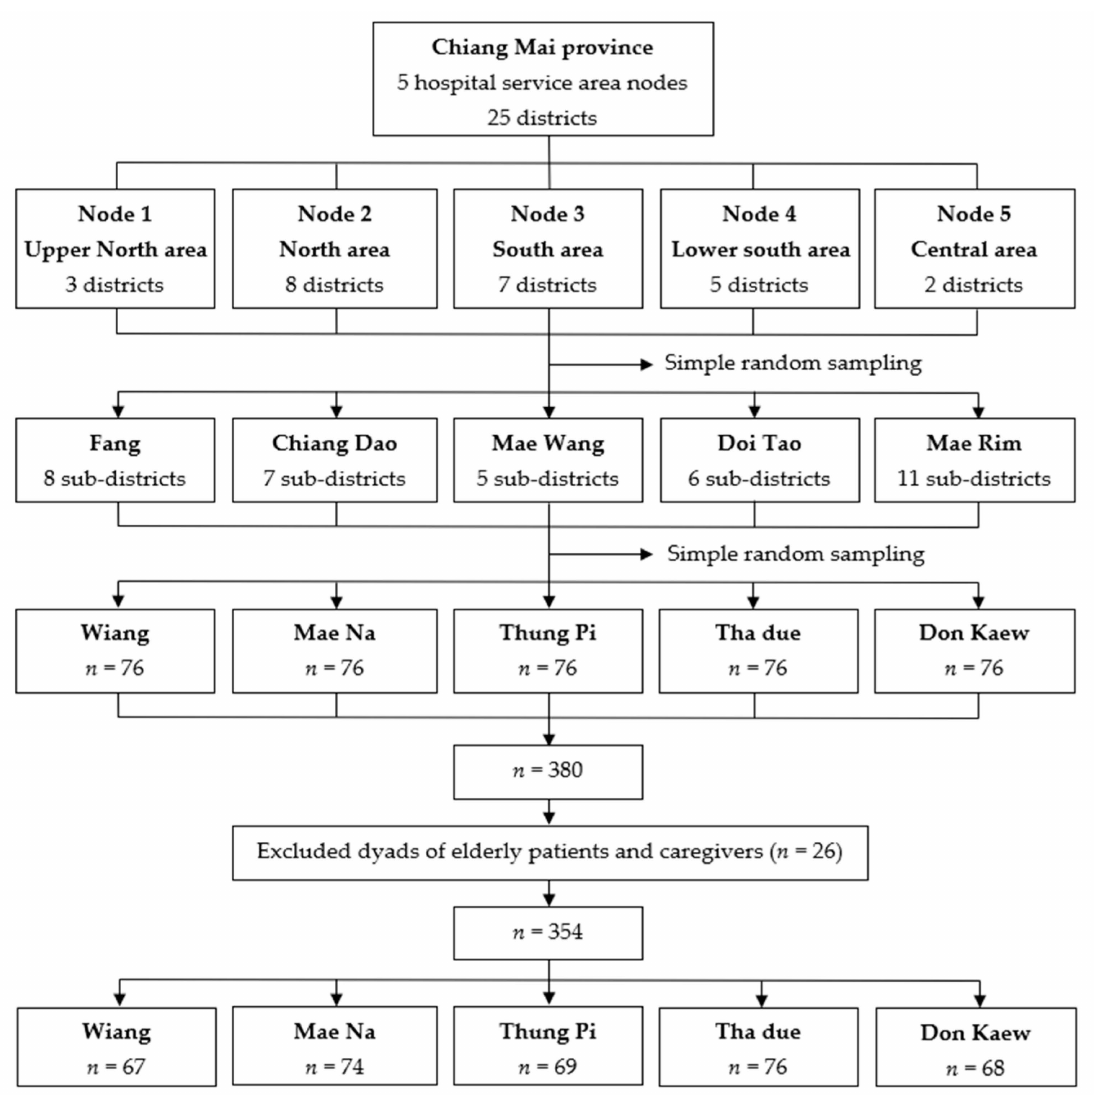
Figure 1. A diagram of the multistage